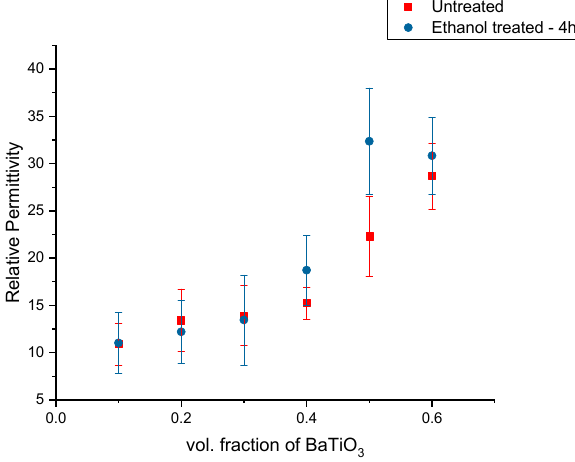
Figure 2. The relative permittivity of the BaTiO 3 -epoxy composite fabricated using BaTiO 3 nanoparticles that were surface modified using ethanol for 4 h is plotted as a function of vol. fraction. The measurements were taken at 20 MHz.